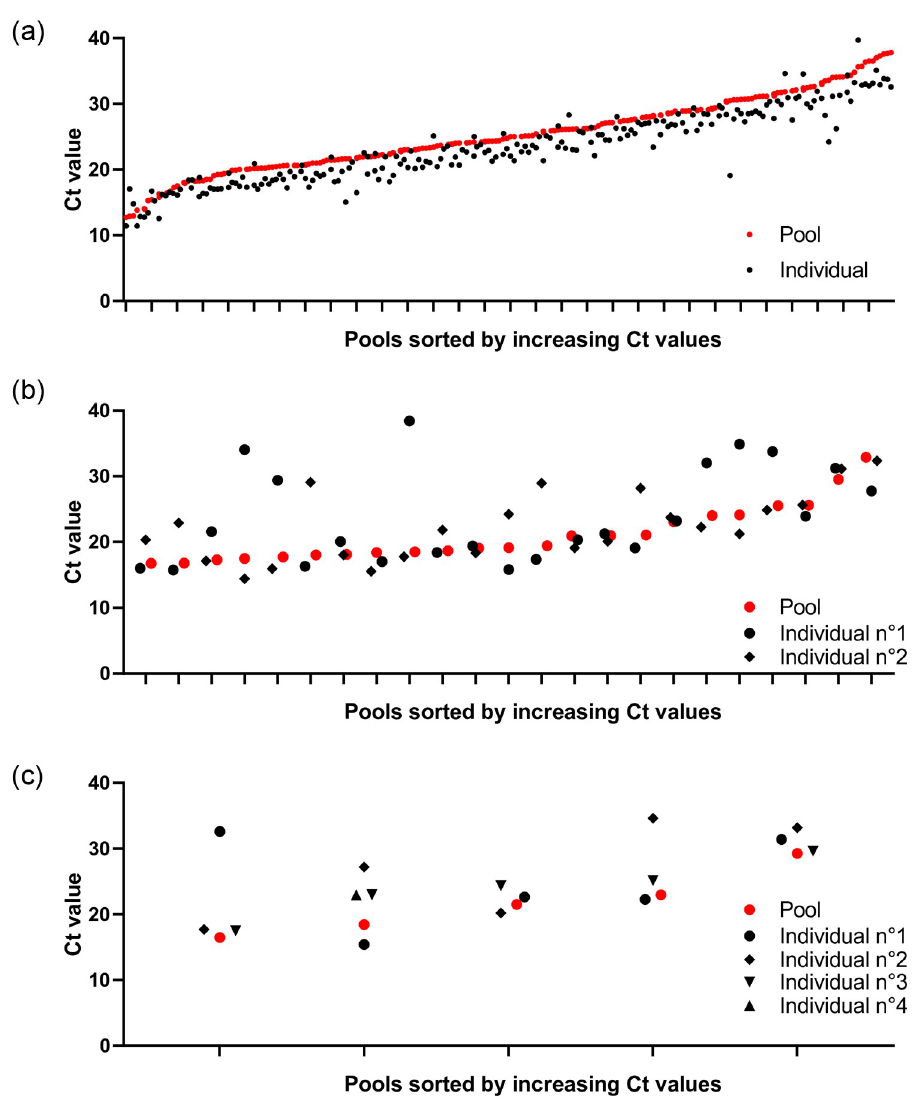
Fig 3. Graph showing Ct values for the detection of SARS-CoV-2 E gene in pools, and of RdRP gene in individual self-collected samples. A) Pools (N = 210) containing 1 positive individual sample; B) Pools (N = 23) containing 2 positive individual samples; C) Pools (N = 5) containing > 2 positive individual